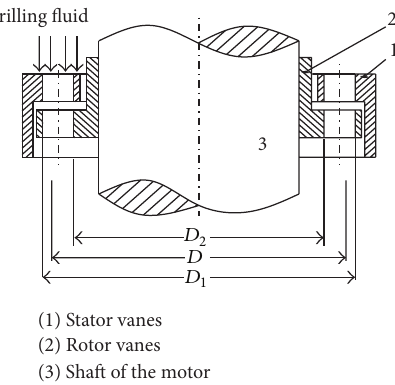
Figure 1: Sketch of the turbodrill blade assembly.